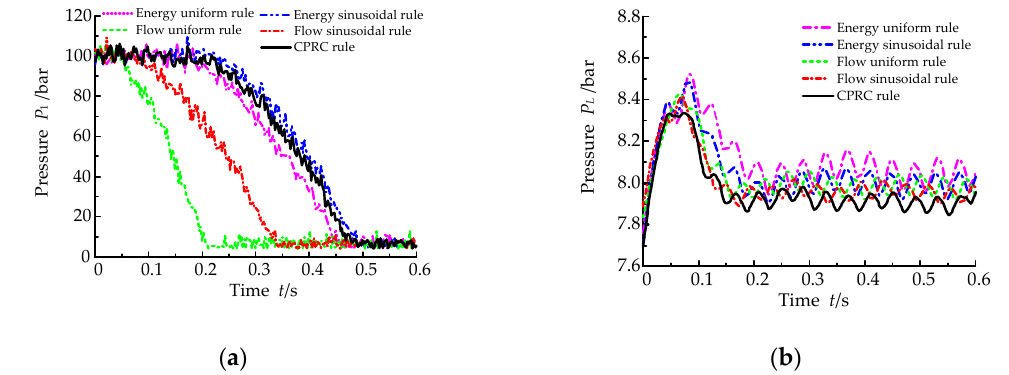
Figure 14. The system response curve under initial pressure of 100 bar. ( a ) Working cylinder pressure; ( b ) Relief-pipe pressure. Processes 2019 , 7 , x FOR PEER REVIEW